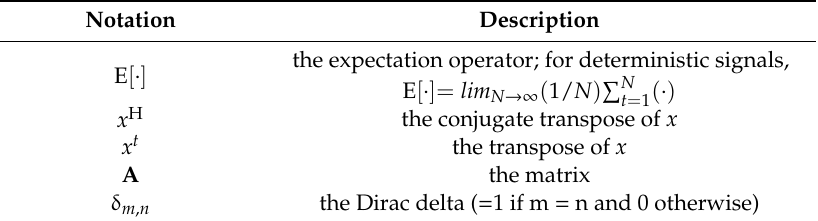
Table 1. Notations in this